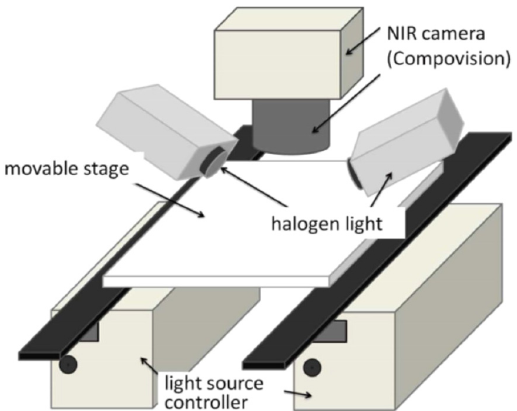
Fig. 2. A schematic of illumination con¯guration. Reproduced from Ref. 10.